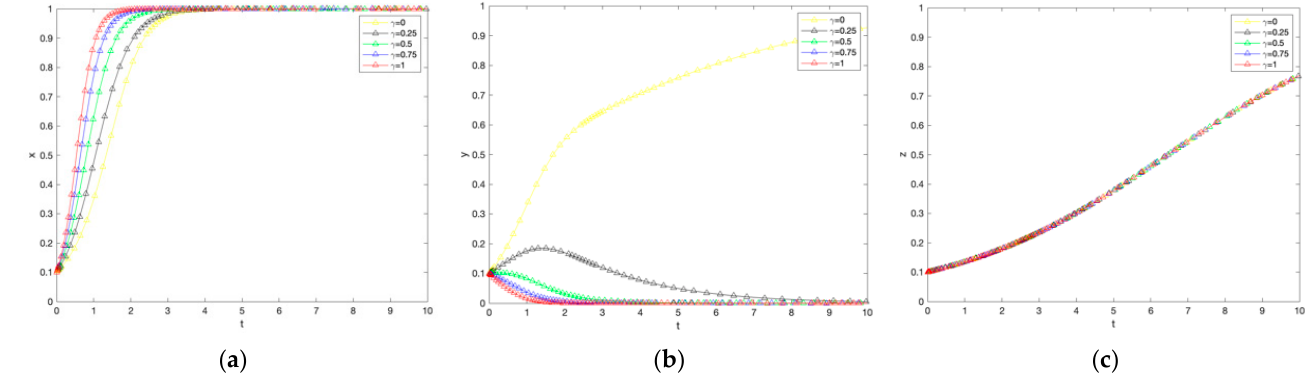
Figure 4. The impact of changes in the penalty coefficient for farmers not producing on government subsidies, farmer adoption, and consumer purchases. ( a ) Government response. ( b ) Farmers’ response. ( c ) Consumer reaction.